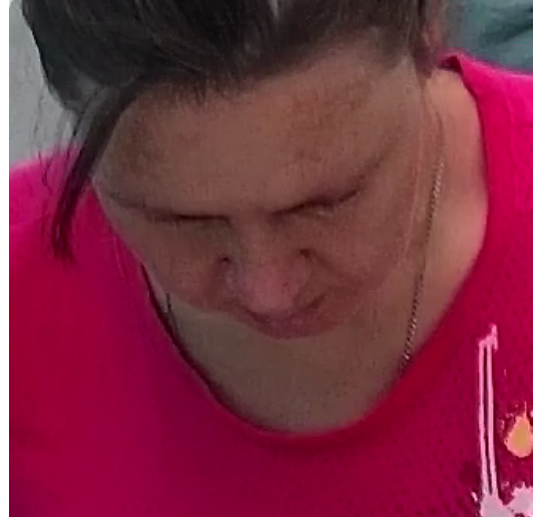
Figure 5. Bad pitch